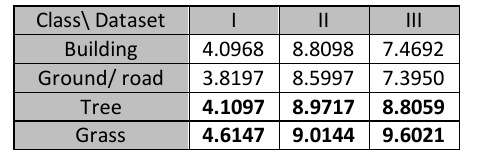
Table 1. The standard deviation of the uncertainty per class (meter)